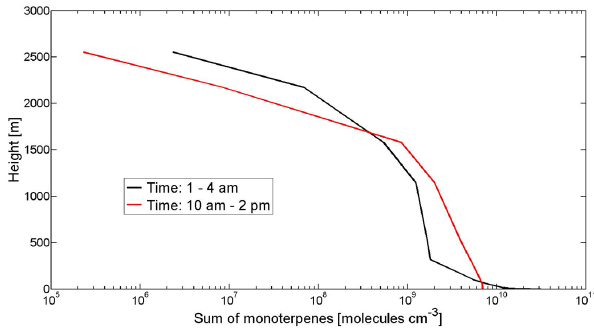
Fig. 3. Modelled and measured temperature and friction velocity for March and August 2007 for SMEAR II, Hyyti¨al¨a at 23m above ground.